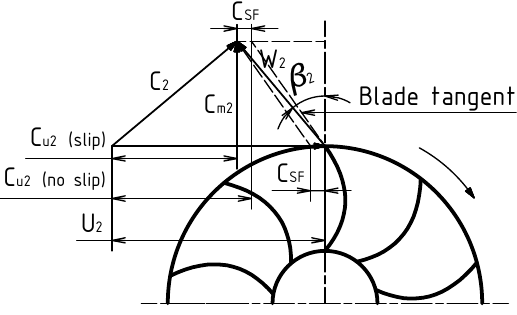
Figure 2. Example of velocity triangles at an impeller outlet with a breakdown into different velocity